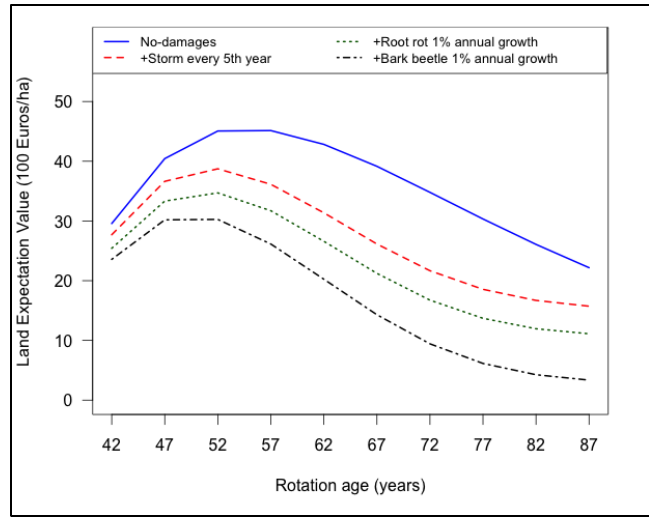
Figure 5. Land expectation values for Norway spruce stand in southern Sweden (SI = G34*) under “No-damages” scenario and adding the risk factors such as storm damage, root rot infection and bark beetle damage to “No-damages” scenario under a changing climate. * The letter represents site index species, G = Norway spruce, and the number in the site index shows the height (m) the stand attains at an age of 100 years